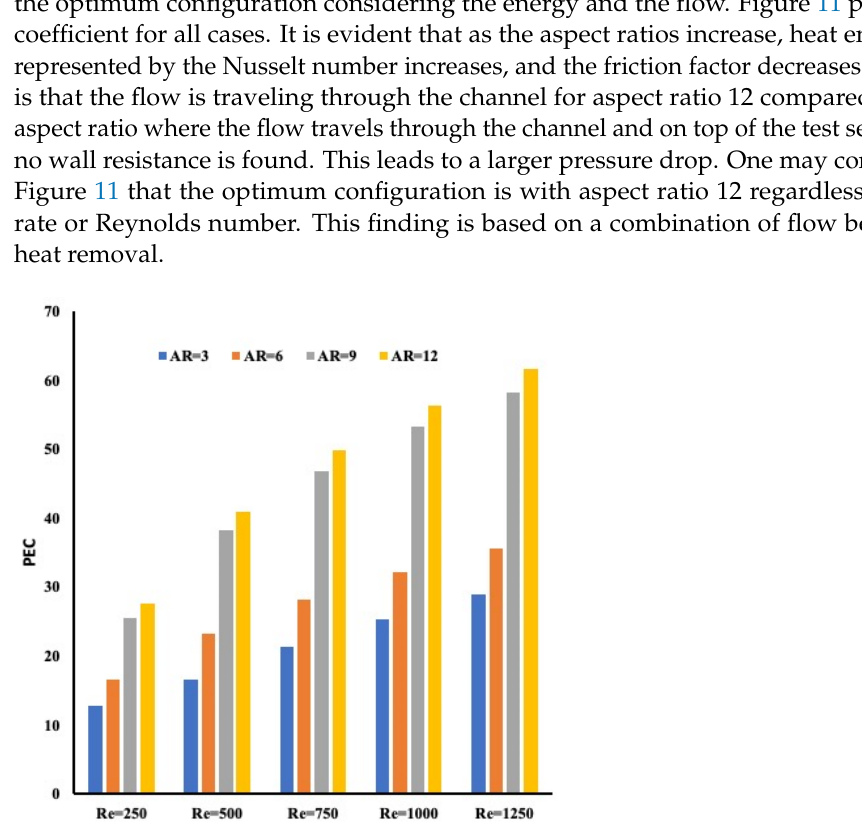
Figure 12. Heat removal for all cases.